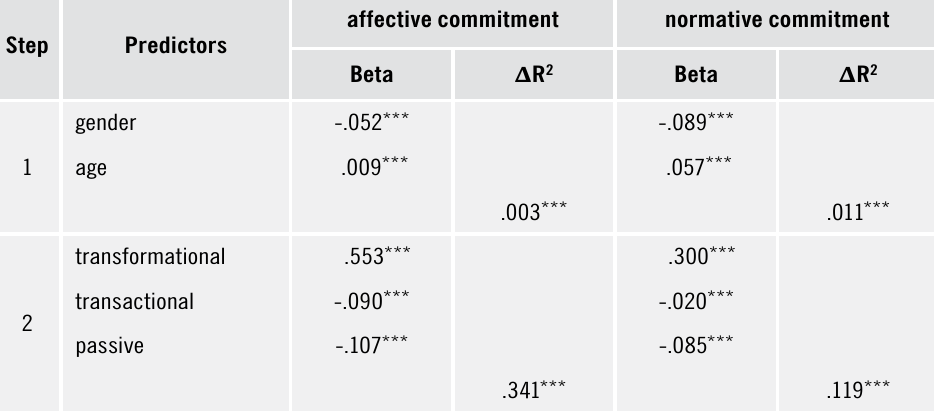
Table 2. Regression analysis affective and normative commitment by